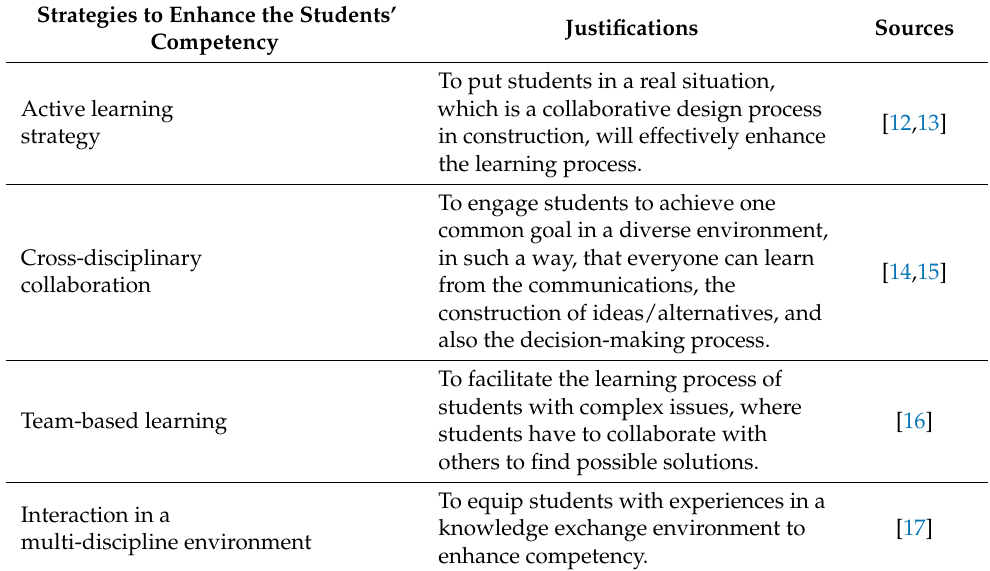
Table 1. Strategies to enhance students’ competency and learning